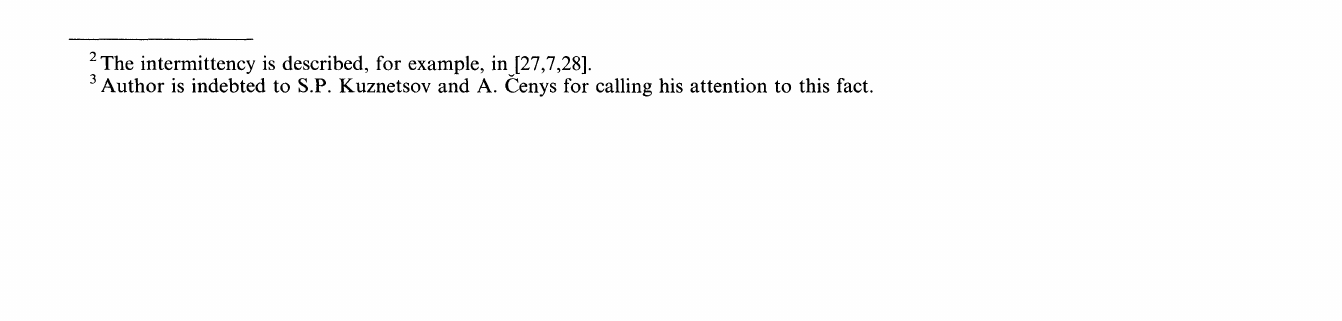
The dependencies q(t) and b(t) for 0v0=l, /3:0.1, c: 100 (a) (2)/cr: 1.01, (b) (2)/cr: 1.2, and (c) (2)/cr:5.6; (d) the dependence of 2 on (2)/cr (the straight line 2 =0.01151 ((2)/r-1) is shown as a solid